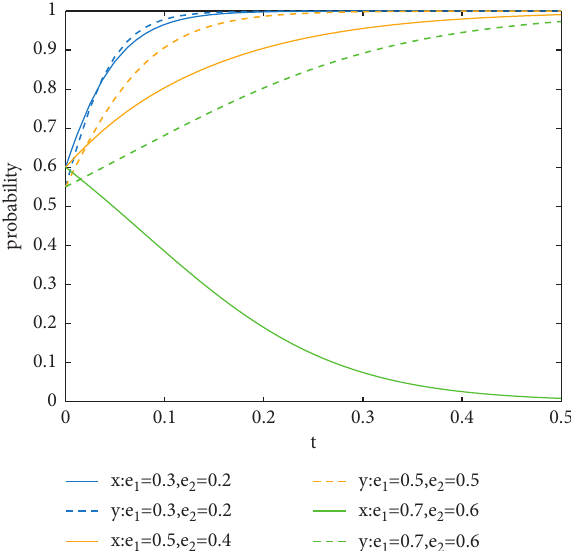
Figure 6: The effects of knowledge absorption and transformation ability on knowledge hiding.